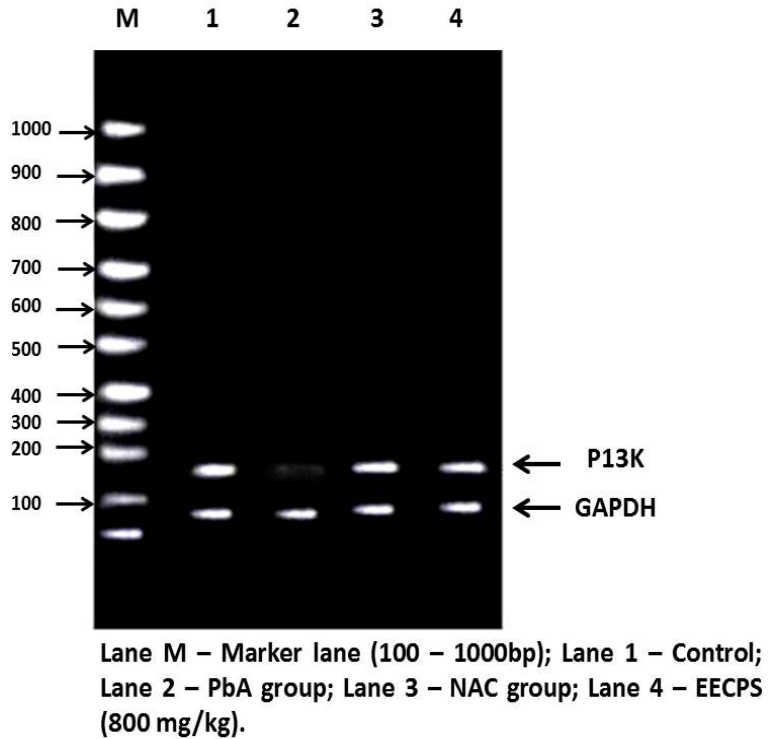
Figure 10. Agarose gel electrophoretic pattern of PI3K mRNA expression in the kidney. The lane identities are indicated below the image.